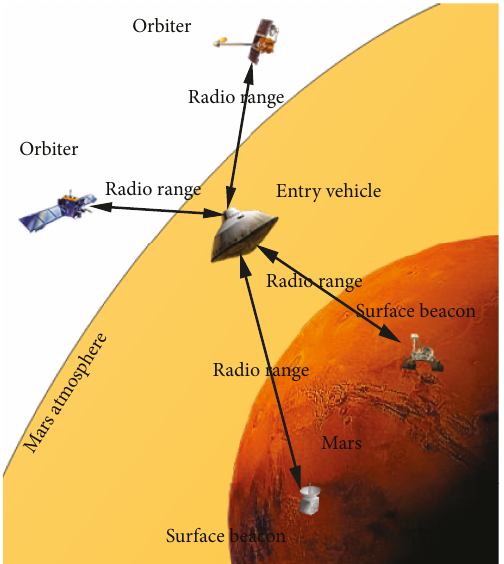
Figure 1: Integrated navigation scenario of IMU/radio measurement based on the Mars